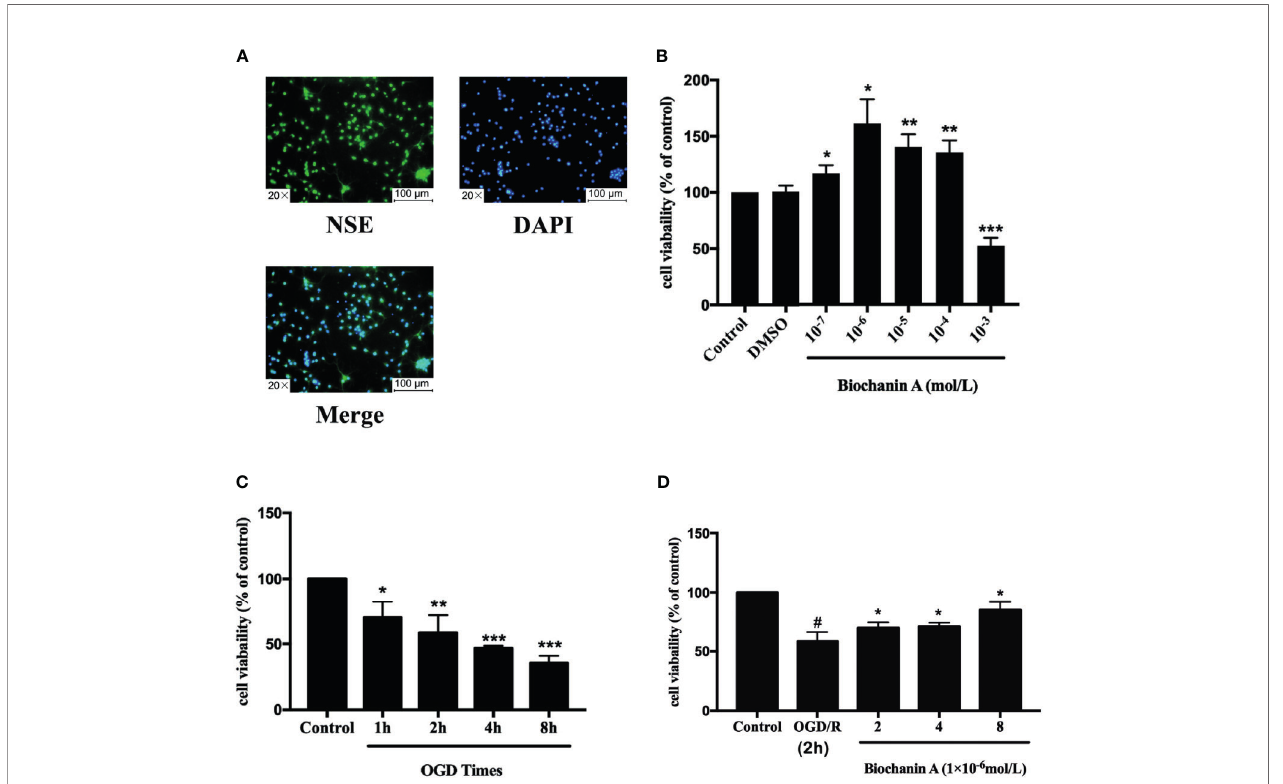
FIGURE 3 | The optimum of concentrations for biochanin A and OGD times on primary cortical neurons. (A) Identi fi cation of primary neurons. (B) Effects of biochanin A at different concentrations on primary neurons. (C) Effects of different OGD times on primary neurons. (D) Effects of biochanin A at different concentrations on primary neurons after 2 h of OGD. Cell viability was detected by CCK8 assay. Results are expressed as the mean ± SE, n = 3. * P < 0.05, ** P < 0.01, *** P < 0.001, vs. the control group or OGD/R group. # P < 0.05, the OGD/R group vs . the control